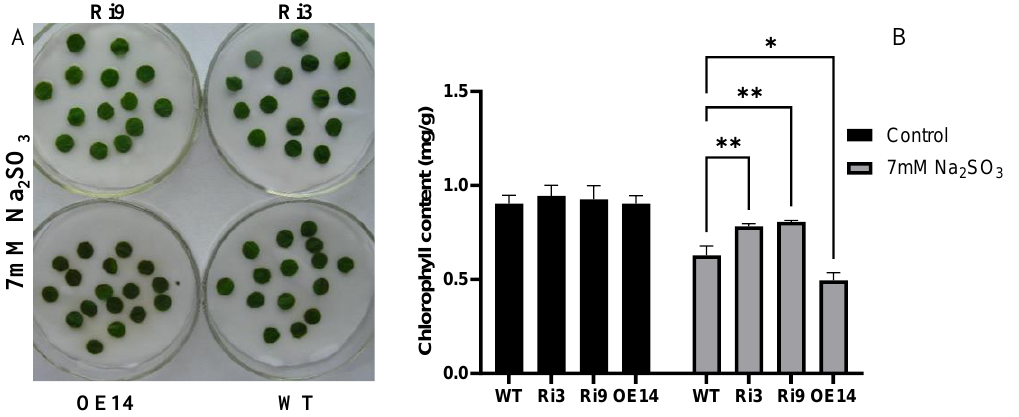
Figure 5. Responses of wild-type and HyPRP1 transgenic lines treated to Na 2 SO 3 . ( A ) Representative photographs of leaf discs from wild type (WT), HyPRP1 RNAi (Ri) and overexpression plants (OE) were treated with 7 mM Na 2 SO 3 for 24 h. ( B ) Chlorophyll content of the no-stress (Control) and Na 2 SO 3 -treated leaf discs. Means SE ( n = 3). The difference between OE or Ri compared to WT indicated * p < 0.05, ** p < 0.01.